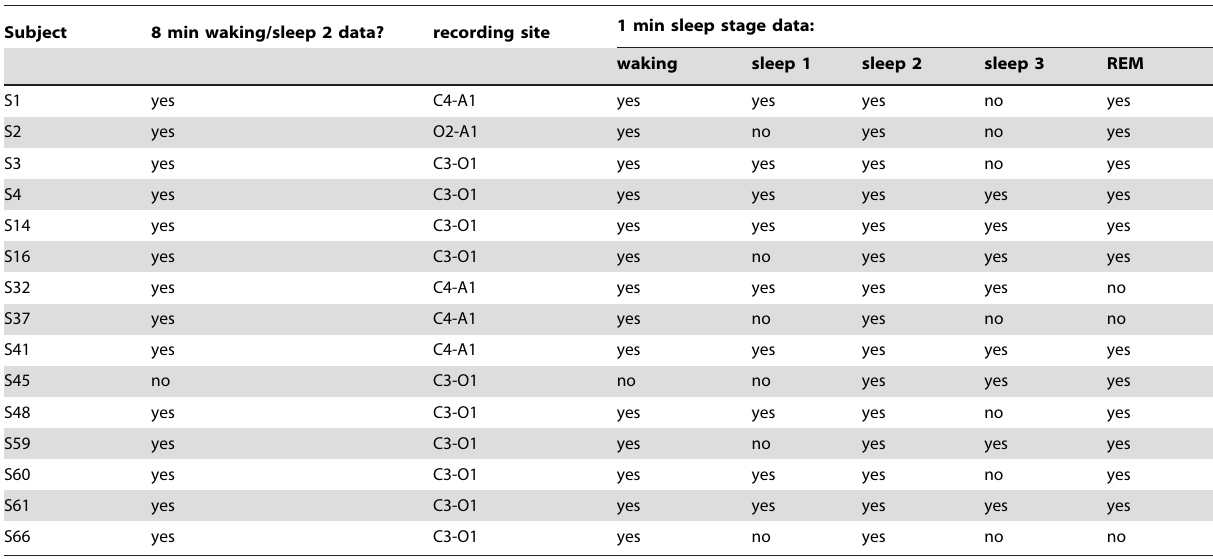
Table 1. List of subject numbers and data utilized.